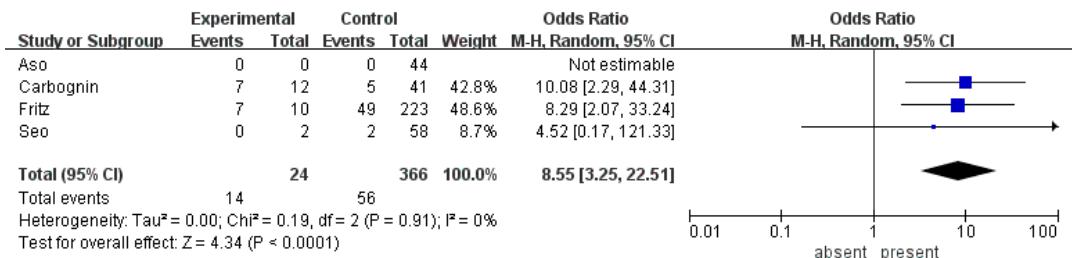
Figure 4. Forest plot demonstrates the incidence of malignancy in BD-IPMN stratified by the presence of lymphadenopathy.